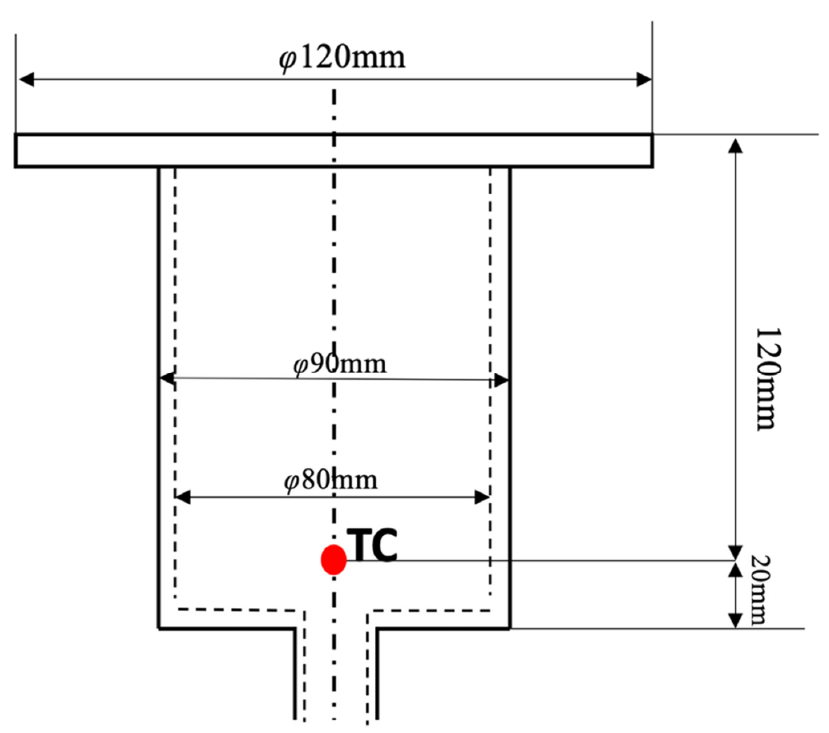
Figure 2. Details of the test vessel and TC location.